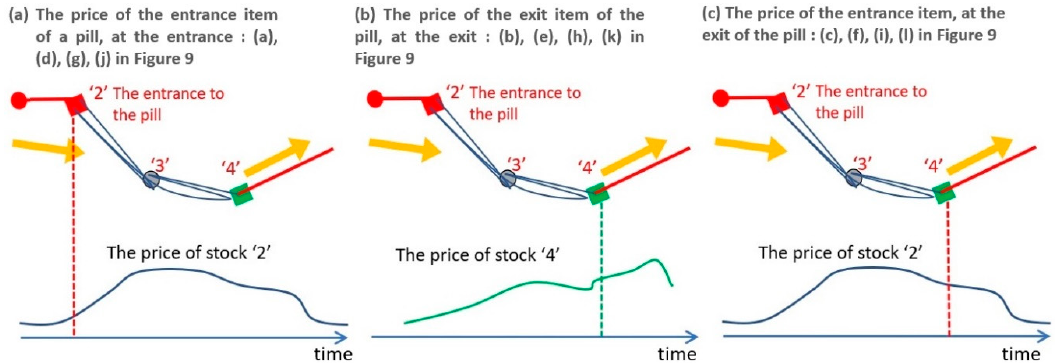
Figure 8. Price changes of stocks at pill entrance/pill-exit, at the entrance/exit. ( a – c ) show the price of an item that appeared at the entrance or the exit that changed as shown in the curve, respectively. The price was evaluated at the time shown by the dotted vertical line.